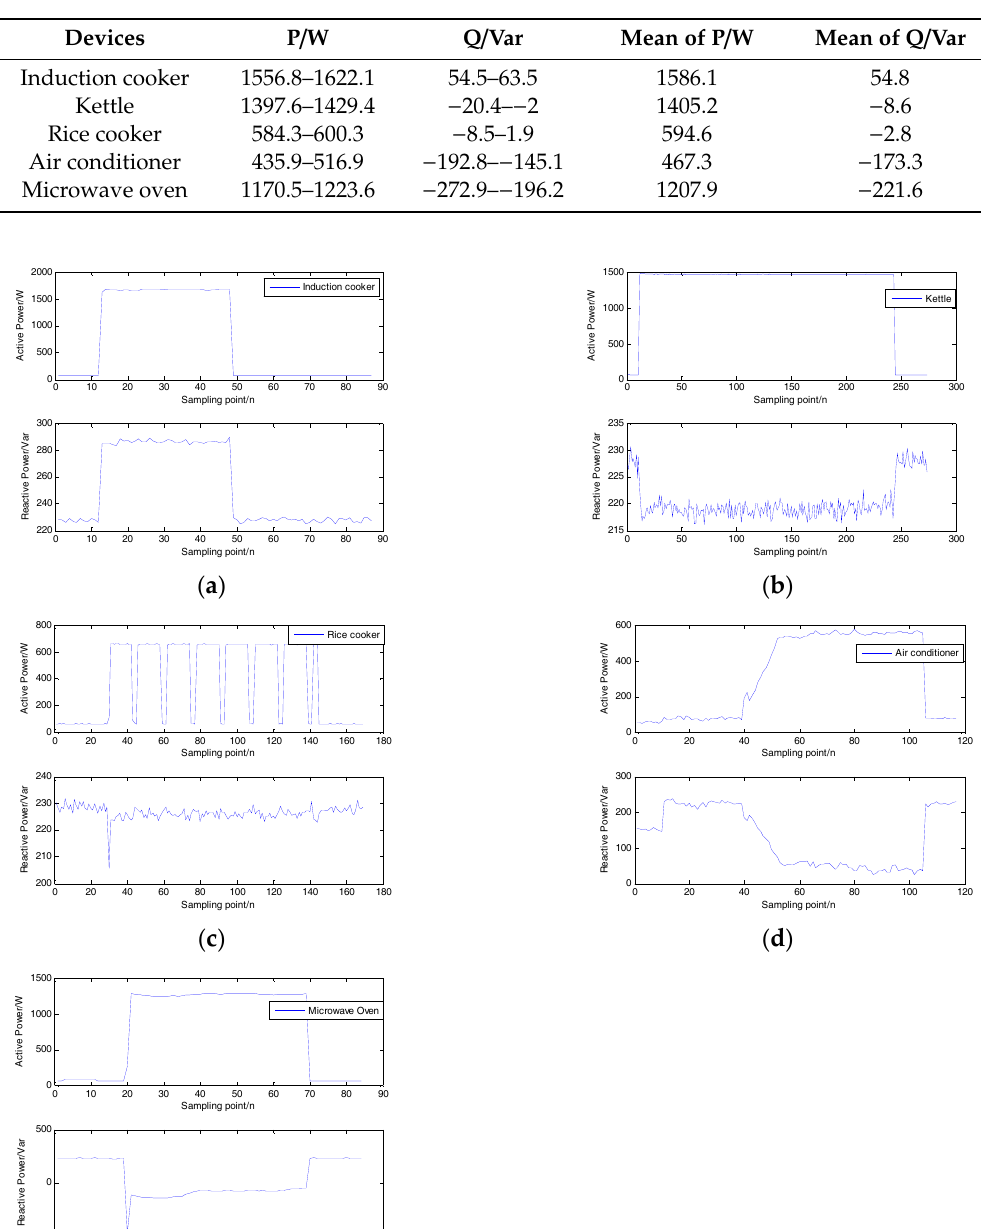
Table 1. Household load power information. P: the active power; Q: the reactive power.